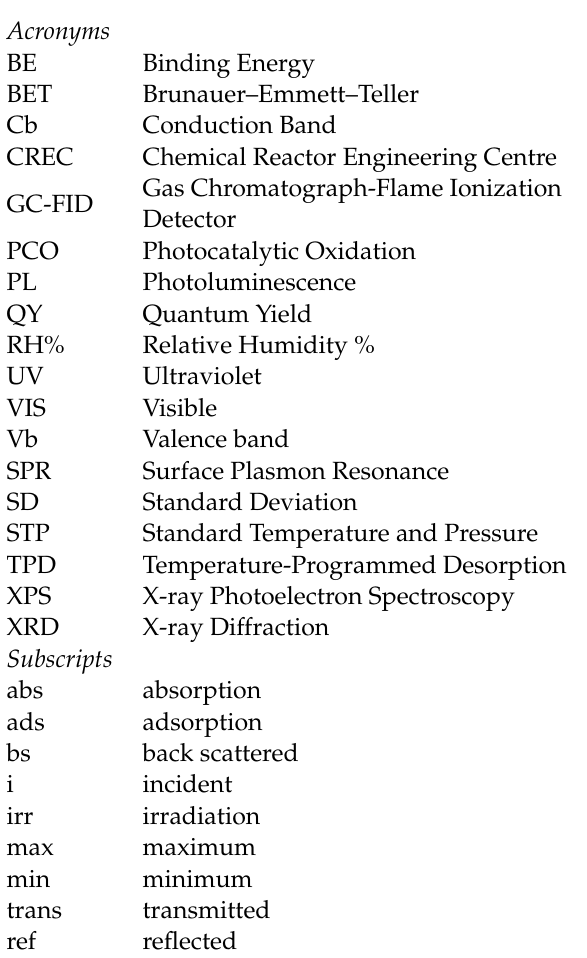
Figure A1. Spectral intensity of near-UV and visible light lamps measured by a Stellarnet Spectrome- ter (EPP3000, 200–1100 nm wavelength